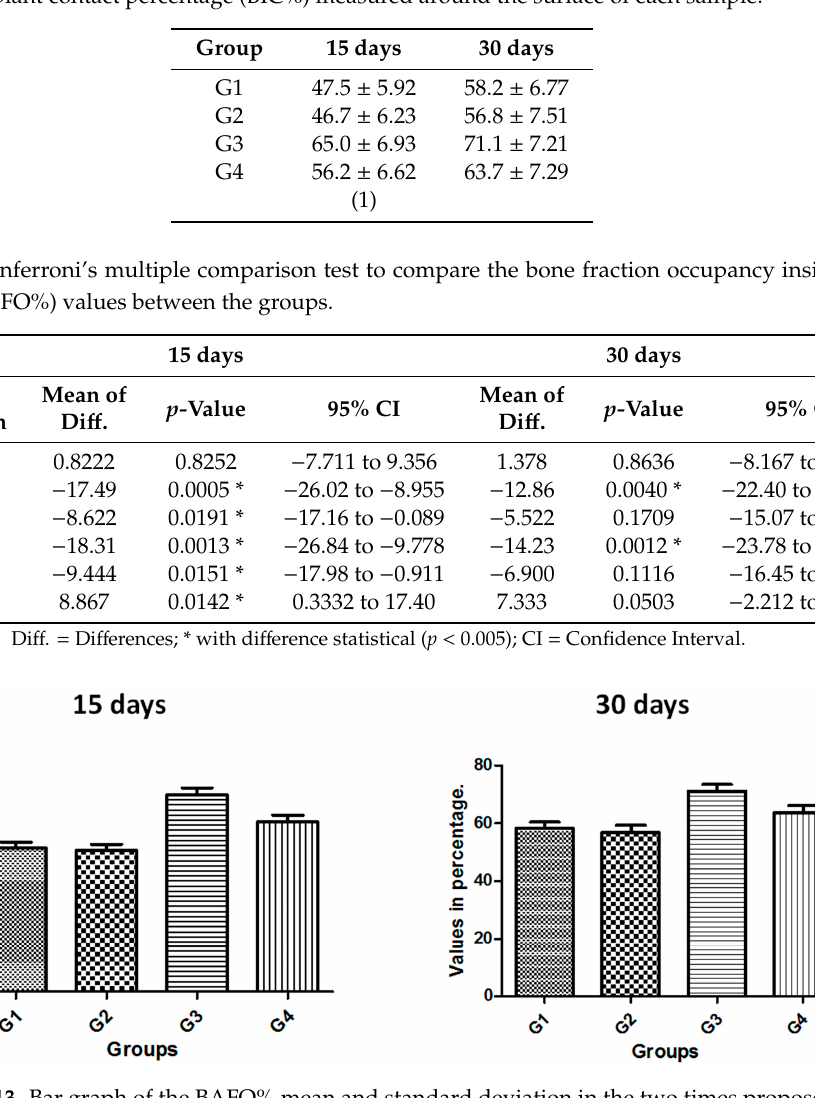
Figure 13. Bar graph of the BAFO% mean and standard deviation in the two times proposed.